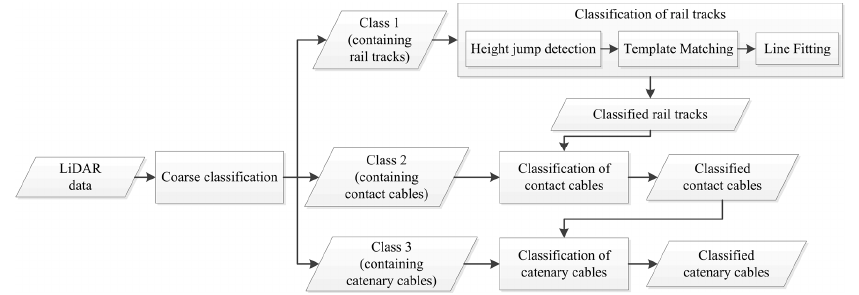
Figure 1. Flowchart of the proposed methodology.